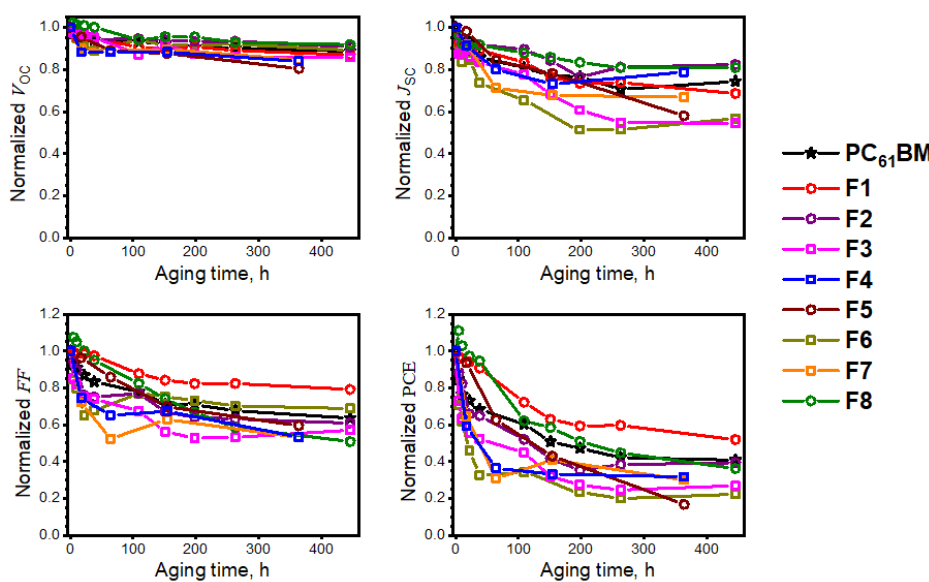
Figure 4. The evolution of the normalized device parameters for PSCs assembled with different ETL materials upon aging under continuous exposure to light in open - circuit conditions.